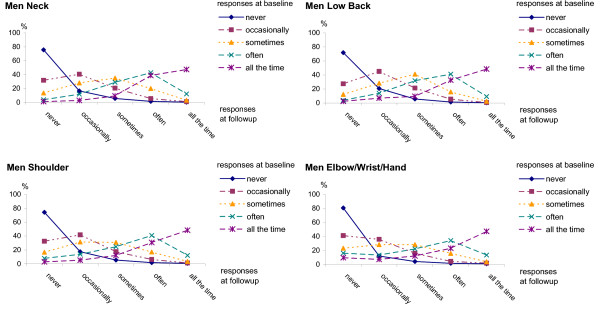
The course of reported symptoms among men; the reported symptoms at baseline and the transition in percentage at the one year follow-up. For instance, of those reporting neck pain "all the time" at baseline, 48% reported neck pain "all the time" also at the follow up.